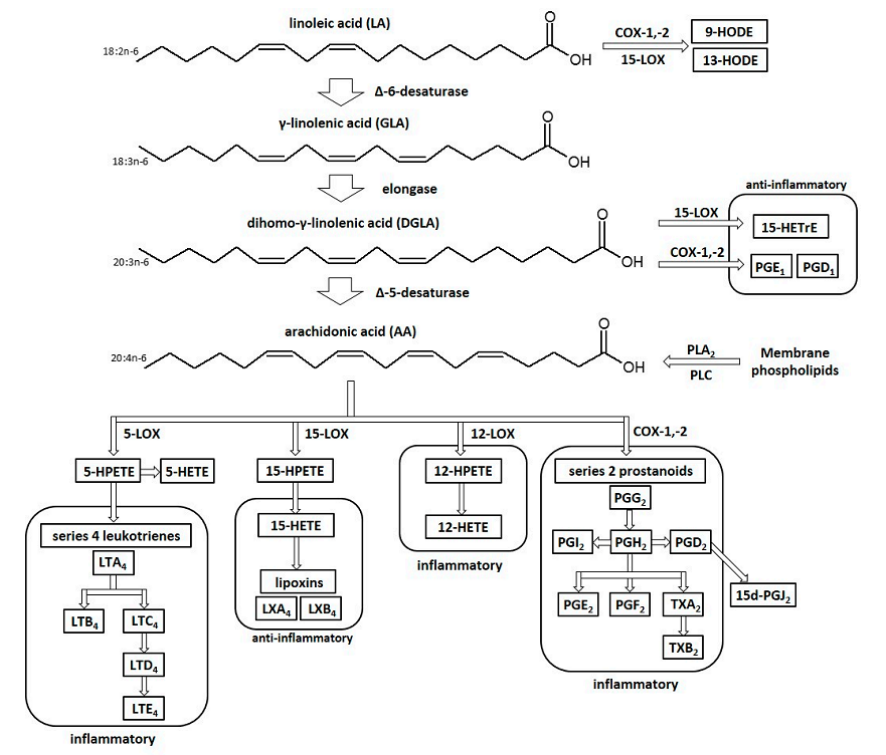
Figure 1. Linoleic acid (LA) metabolism. 9-HODE: 9-hydroxyoctadecadienoic acid; 13-HODE: 13-hydroxyoctadecadienoic acid; 15-HETrE: 15-hydroxyeicosatrienoic; PGE 1 : prostaglandin 5-hydroperoxyeicosatetraenoic acid; 5-HETE: 5-hydroxyeicosatetraenoic acid; LTA 4 :